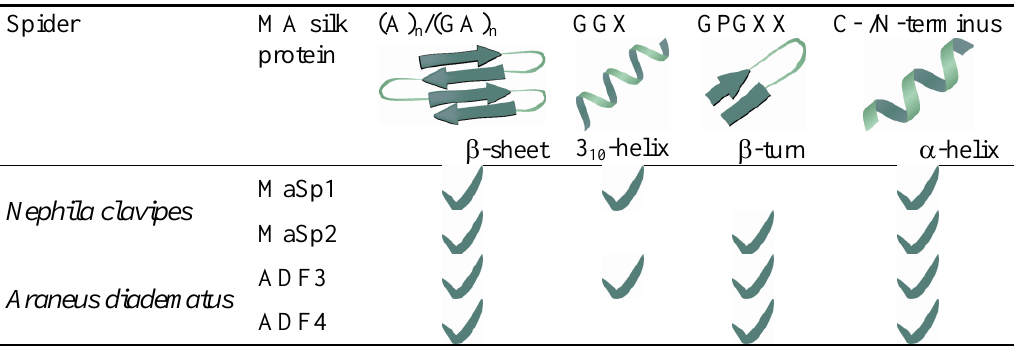
Table 1. Repetitive motifs and corresponding secondary structures as present in N. clavipes and A. diadematus MA silk (data taken form [105]).